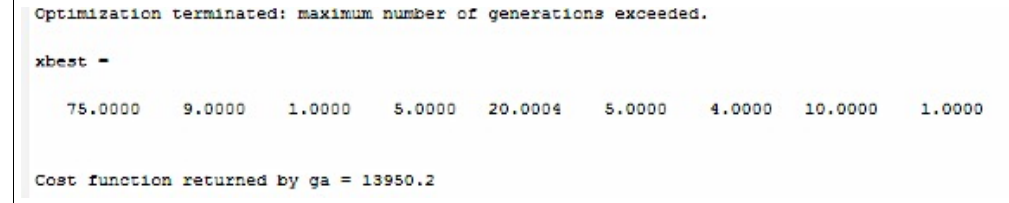
Figure 6. Optimal Sizing of System Components for